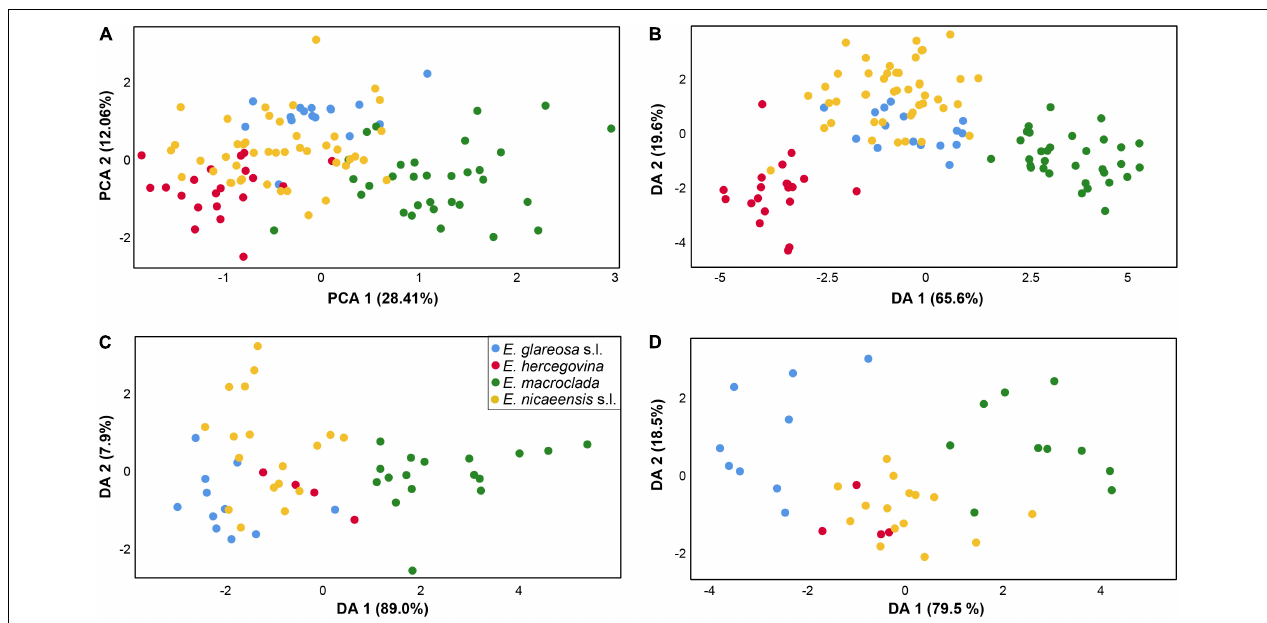
FIGURE 7 | Morphological differentiation amongst Euphorbia glareosa s.l. (blue) , E. hercegovina (red), E. macroclada (green), and E. nicaeensis s.l. (yellow). Principal component analysis (PCA; A ) and discriminant analyses (DA) based on (B) 21 metric and nine ratio vegetative and cyathium characters, (C) four metric and two ratio fruit characters, and (D) six metric and four ratio seed